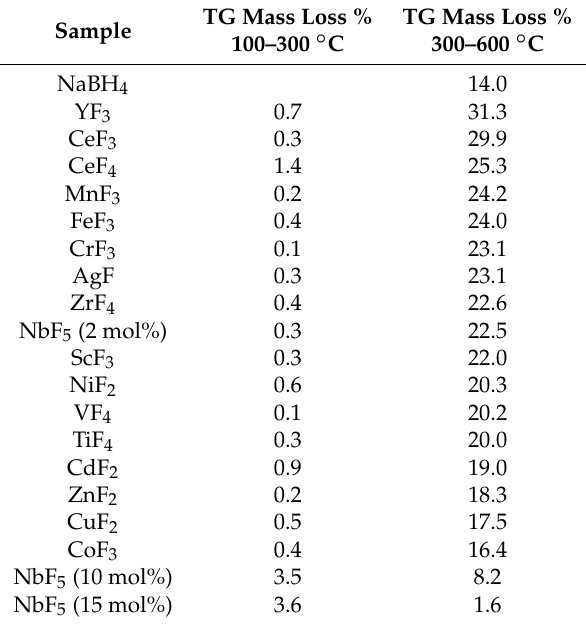
Mass loss measured by TG in the 100–300 ◦ C and 300–600 ◦ C temperature ranges. The tabulated values correspond to the minima of the measured data in every region. Samples are ordered from larger to smaller losses following Figure